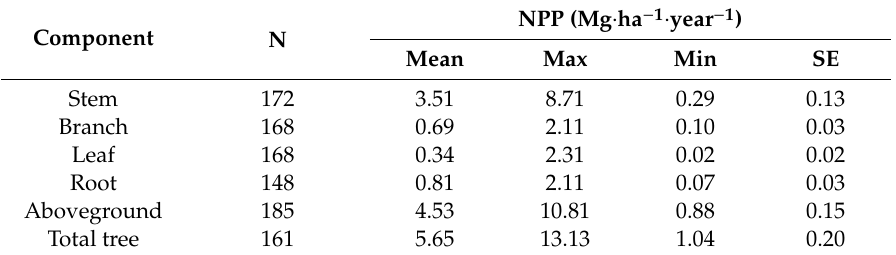
Table 1. Net primary productivity (NPP) of P. massoniana stem, branch, leaf, root, aboveground organs, and total tree. Number of observations (N), mean value (Mean), maximum value (Max), minimum value (Min) and standard error (SE) were